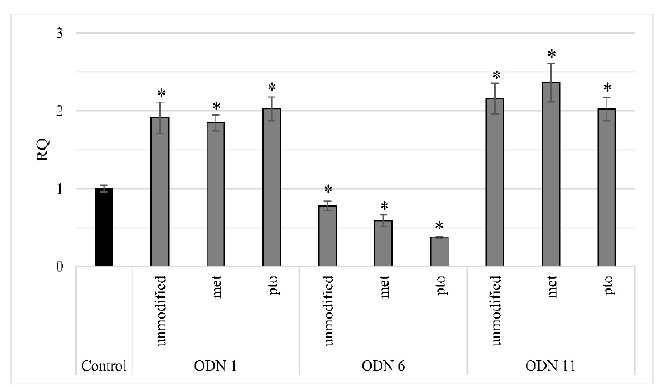
Figure 3. CHS gene expression in in vitro plants treated with modified ODNs after 10 days of incubation. The 4-week-old plants cultured in vitro were incubated with particular sequences of previously analyzed ODN 1, 6 and 11: unmodified ODN, ODN met (sequence with methylated cytosines) and ODN pto (sequence with thiophosphate bonds). The total expression of the two CHS genes LuCHS6 and LuCHS7 was determined by the real-time PCR reaction in plants harvested 10 days after incubation. The values are referred to the reference gene expression actin. The relative quantity (RQ) presents the transcript level in comparison to the control (set as 1, black). Data represent the mean value ± SD from at least three independent experiments. The significance of the di ff erences between each mean and control was determined by Student’s t -test. Asterisk indicates * p < 0.05.